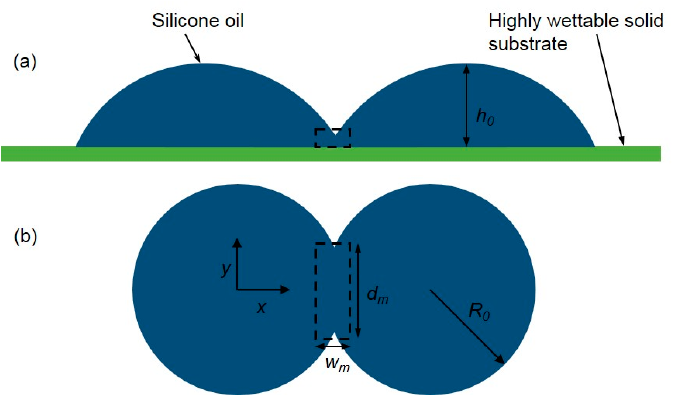
Figure 10. Sketch of two silicone oil droplets coalescing on a highly wettable flat substrate. ( a ) Elevation view; ( b ) plan view. Dashed lines indicate the control volume around the meniscus bridge.